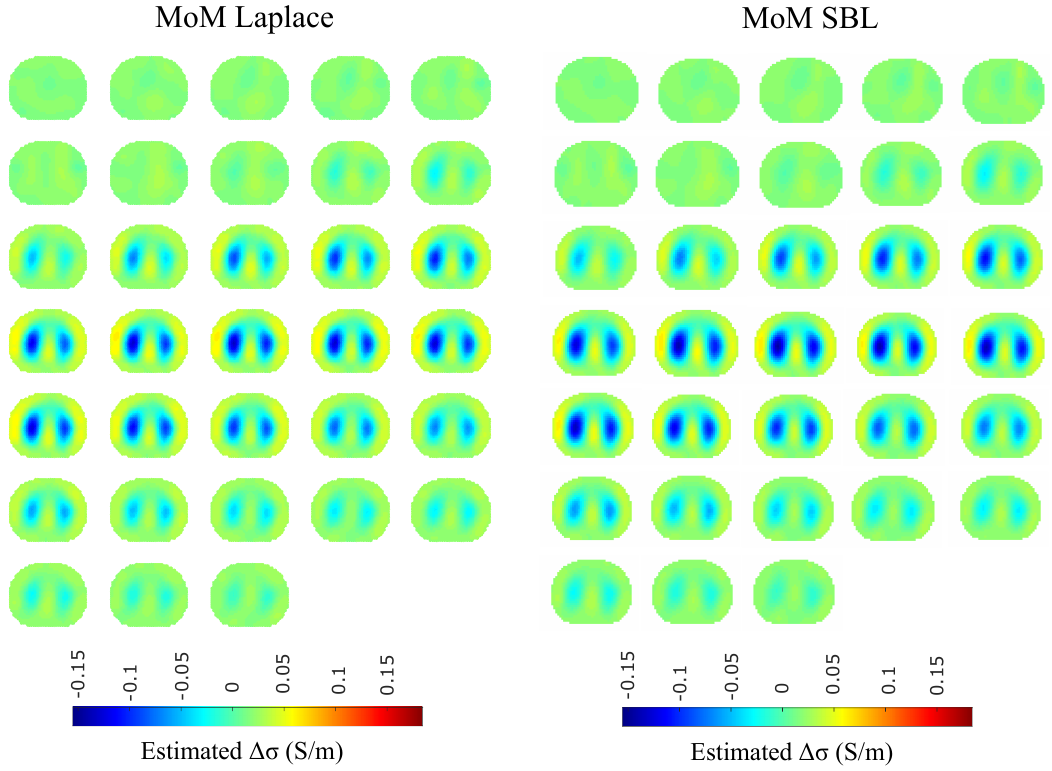
Figure 18. Single–breath in vivo results using the PM-MoM with Laplace regularization prior and the PM-MoM SBL